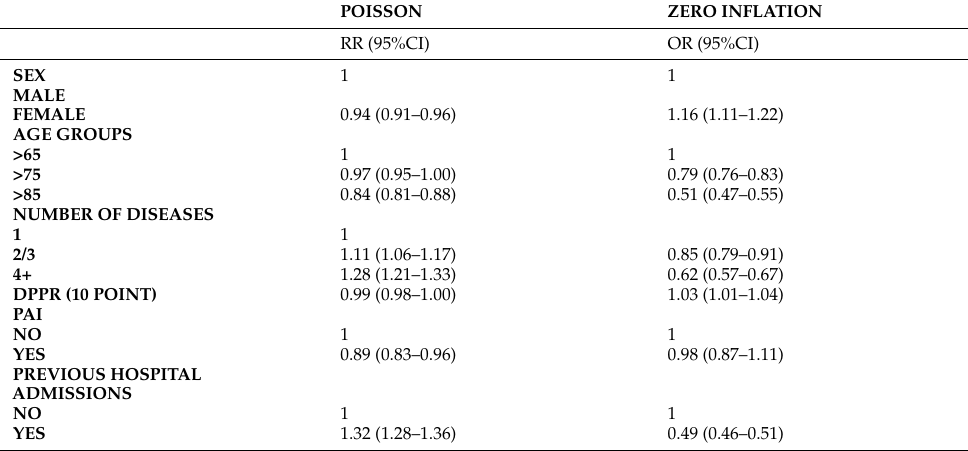
Table 5. Zero-inflated Poisson regression model for assessing factors associated with the number of hospital admissions (rate ratio and corresponding 95%CI (Poisson regression); odds ratios and corresponding 95%CI (zero